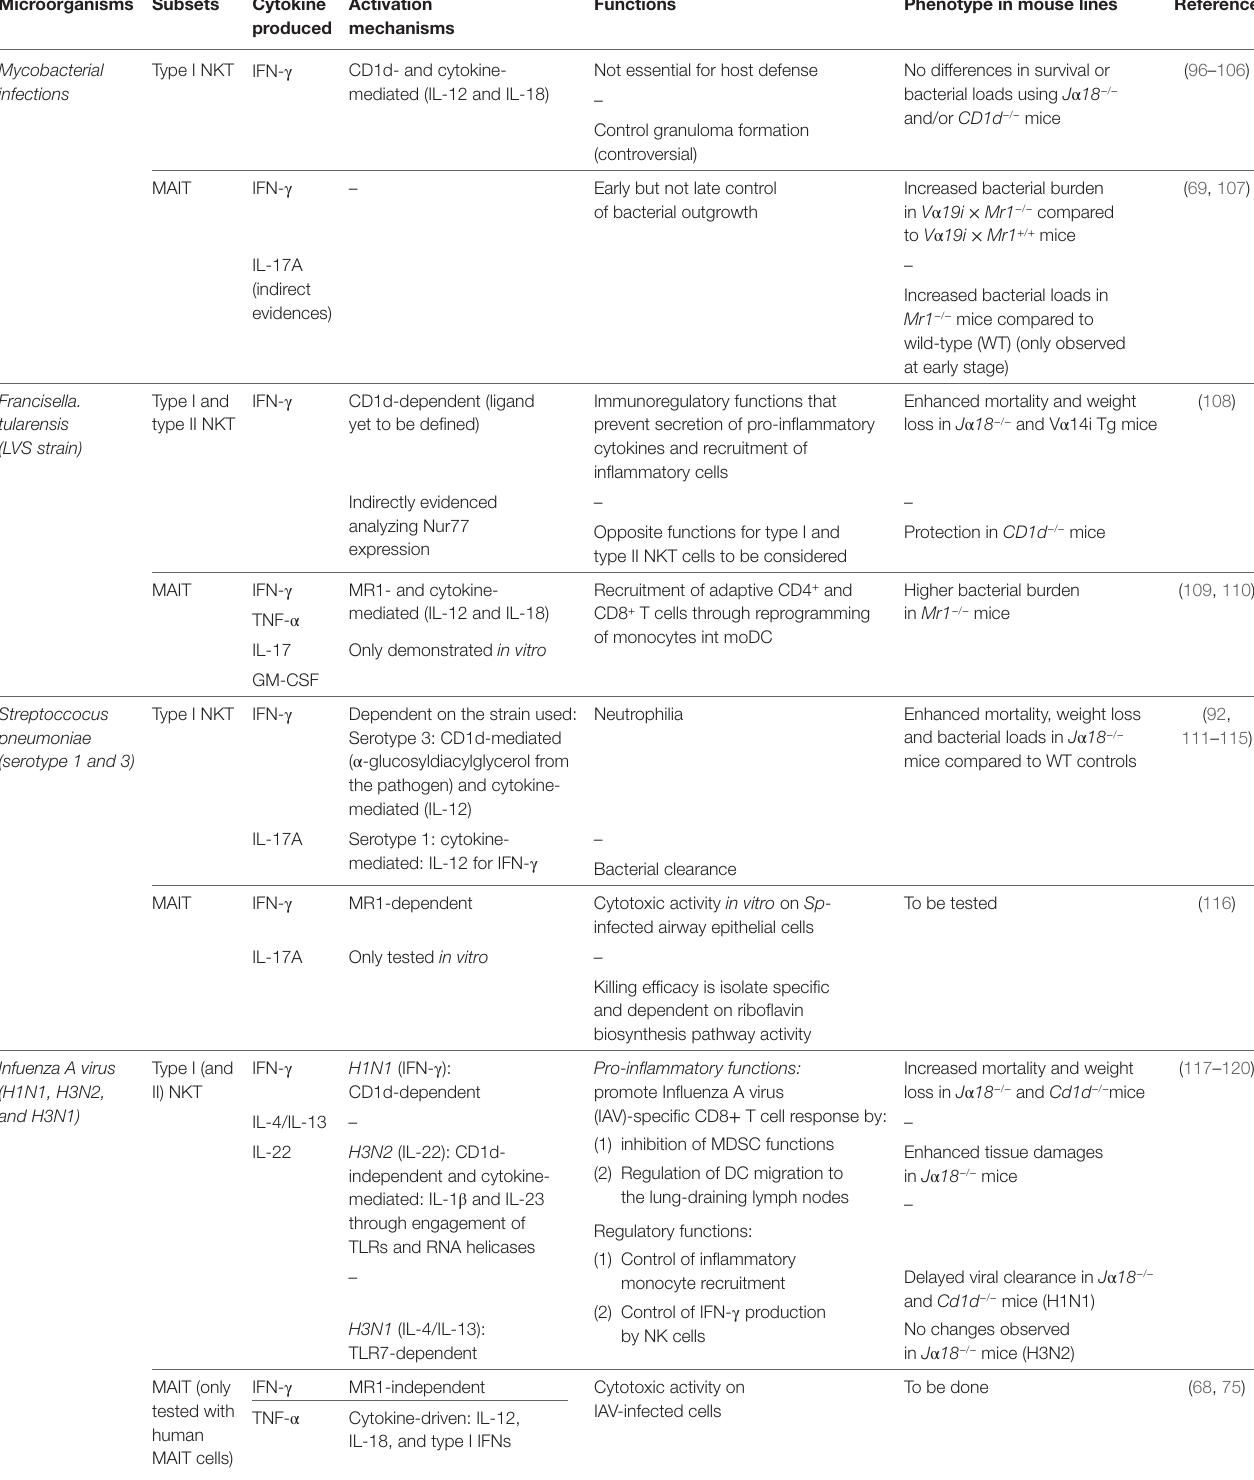
TAbLe 2 | In vivo role of natural killer T (NKT) cells and mucosal-associated invariant T (MAIT) cells in lung